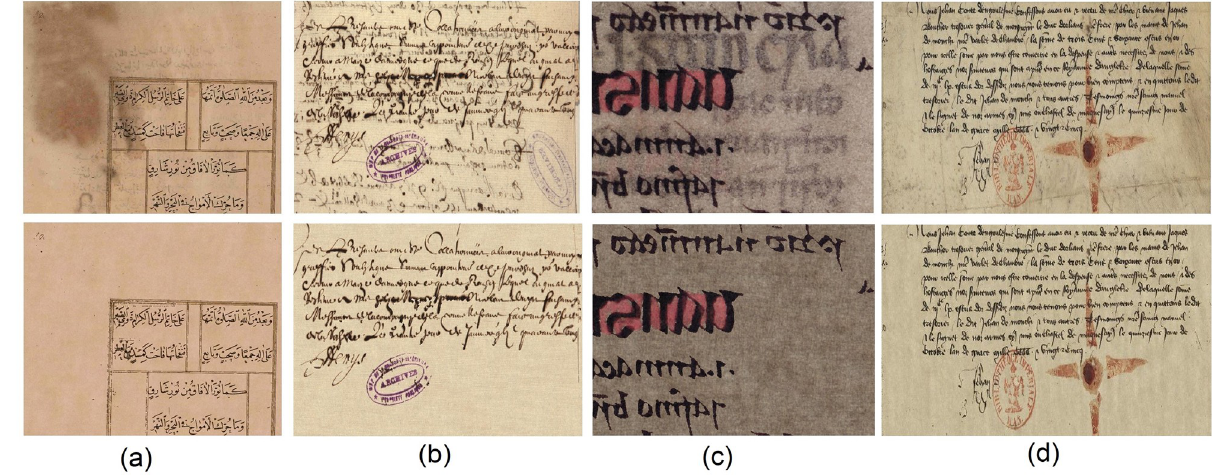
Fig 3. Visual examples of color document images: Input degraded image (top row), restored image using the proposed method (bottom row).